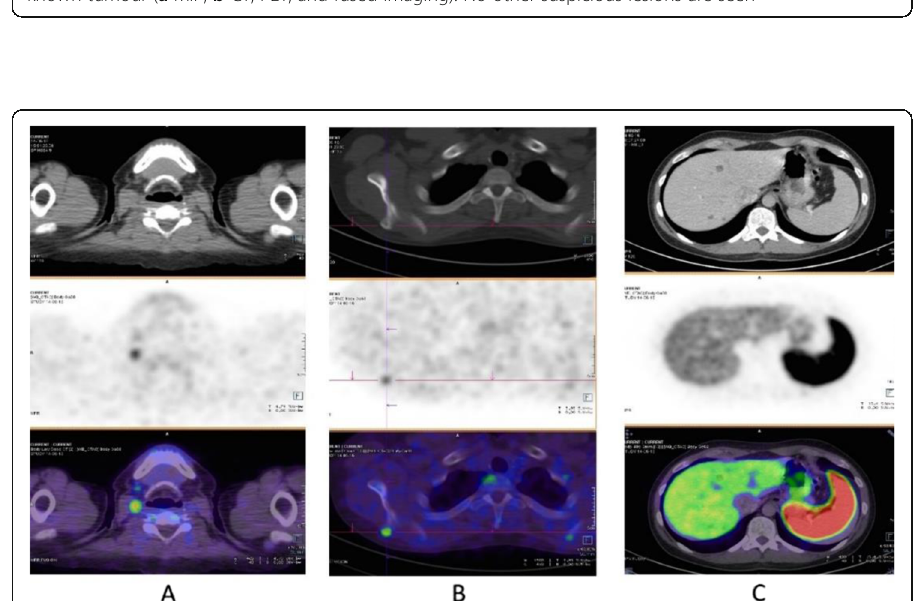
Fig. 63 68 Ga-DOTA peptide, recurrent medullary thyroid cancer (MTC). Clinical history : 56 y.o. man with previous history of MTC, treated by surgery. Progressive increase in calcitonin (TCT = 19200). PET/CT findings : increased uptake in cervical LN ( a ) and bone lesion ( b right scapula). Additional hepatic metastases are seen on the diagnostic CT, but due to the high background they are not evident on PET images ( c